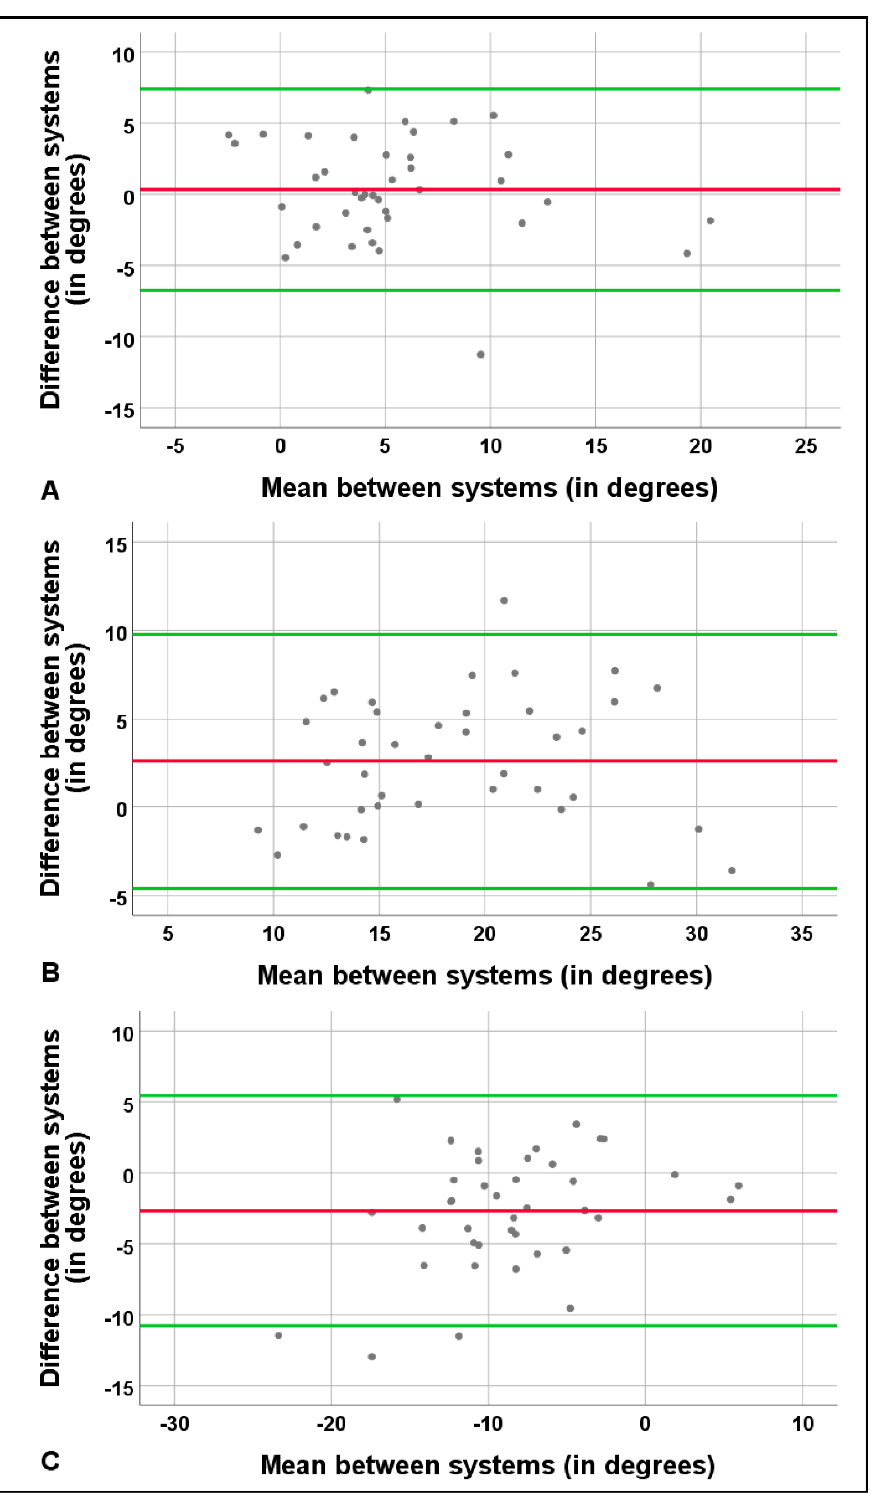
Figure 1. Bland–Altman plots for baseline ( A ), toe–out ( B ), and toe–in ( C ) gait. Every grey dot represents one leg. Difference in FPA between IMUs (Opal sensors) and the PSW (Zeno™ Walkway) is displayed on the y–axis, and the mean FPA for Opal and Zeno™ is displayed on the x–axis. The red line represents the mean difference and the green lines the 95% limits of agreement.